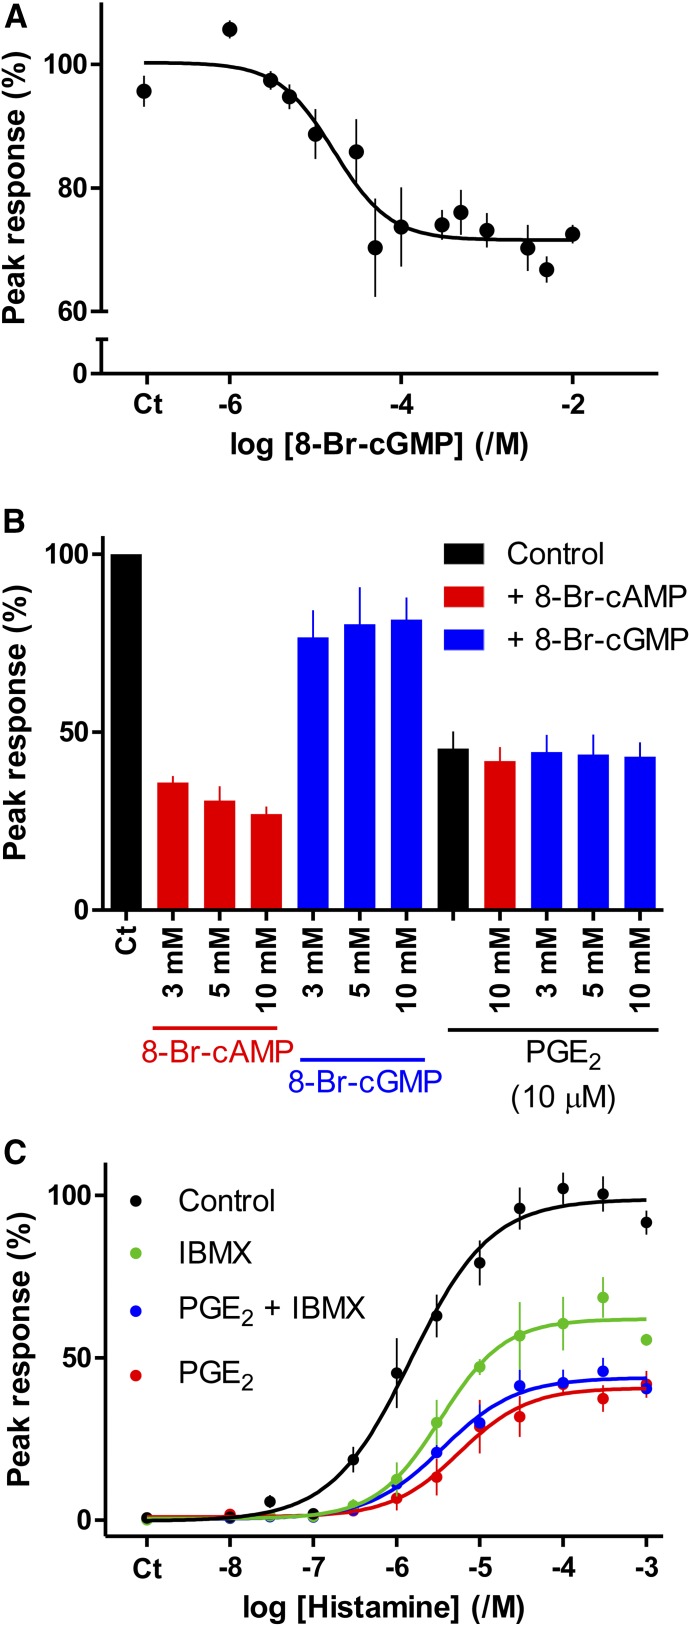
Inhibition of histamine-evoked Ca2+ signals by PGE2 is not mediated by cGMP. (A) Concentration-dependent effects of 8-Br-cGMP (20 minutes) on the peak Ca2+ signals evoked by histamine (3 μM). (B) Similar experiments show the responses to histamine (3 μM) after preincubation with PGE2 (10 μM, 5 minutes) and/or the indicated concentrations of 8-Br-cAMP or 8-Br-cGMP (20 minutes). (C) Peak Ca2+ signals evoked by histamine alone or after incubation with IBMX (1 mM, 20 minutes), PGE2 (10 μM, 5 minutes), or both. Results (as percentages of response to histamine alone) are means ± S.E.M. from five (A), three to six (B; n = 2 for 3 and 5 mM 8-Br-cAMP, where ranges are shown), and four to seven (C) independent experiments with two to three wells in each.